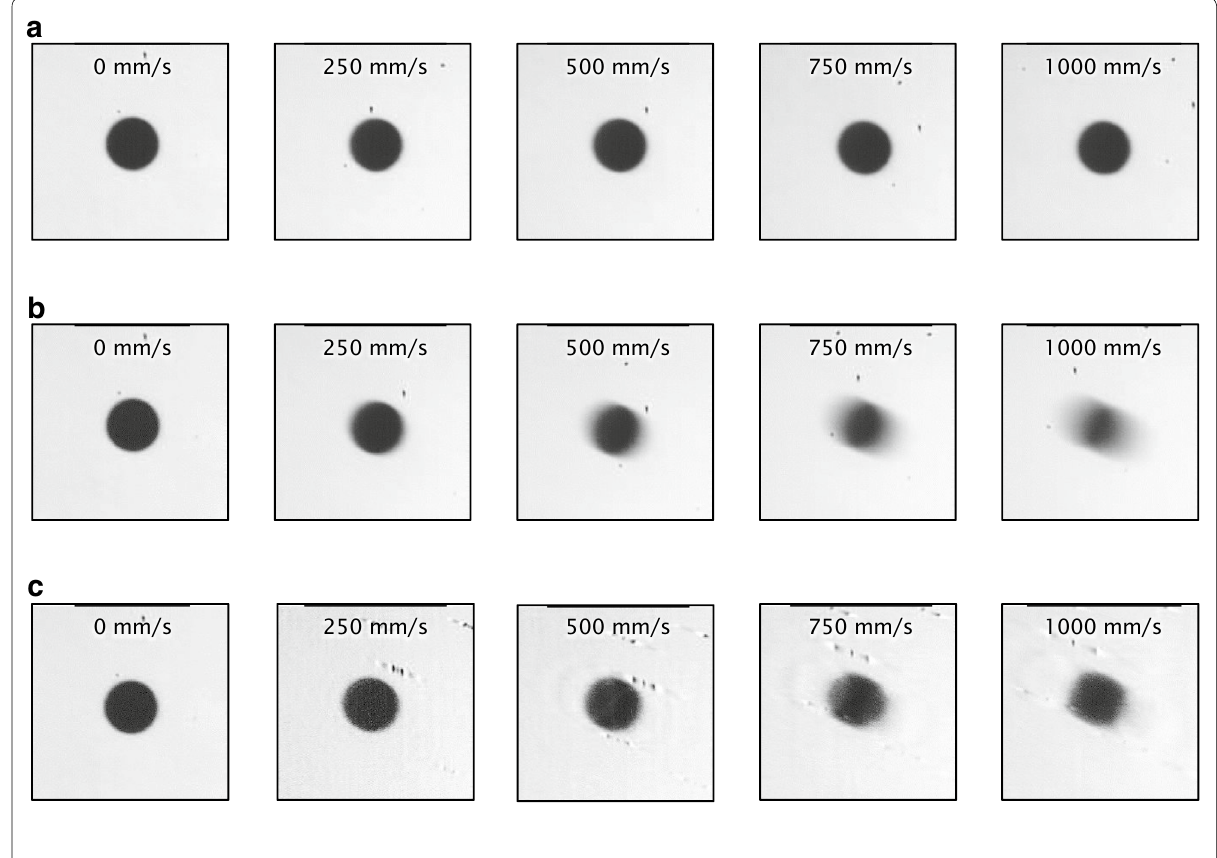
Fig. 13 Images captured when the circle dot moved in the oblique direction. a With tracking (IT). b Without tracking (NT). c Motion deblurring (MD)